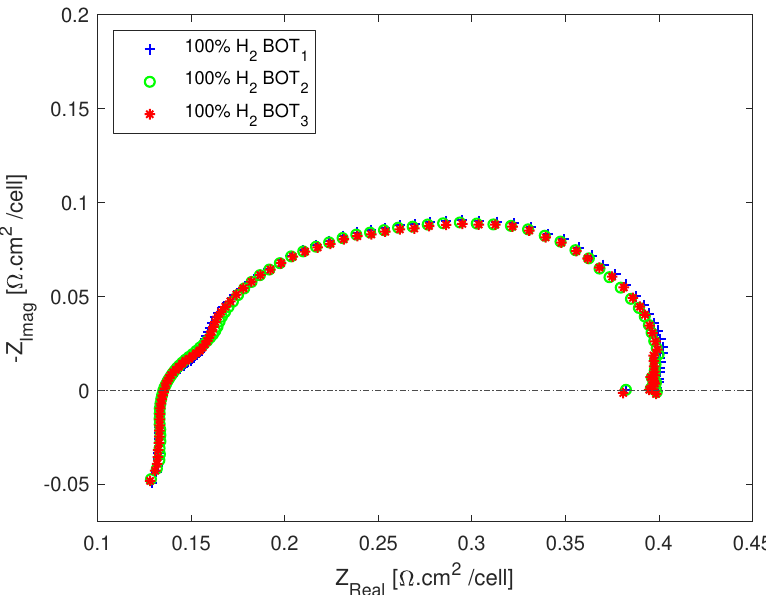
Figure 2. Repeatability of the EIS